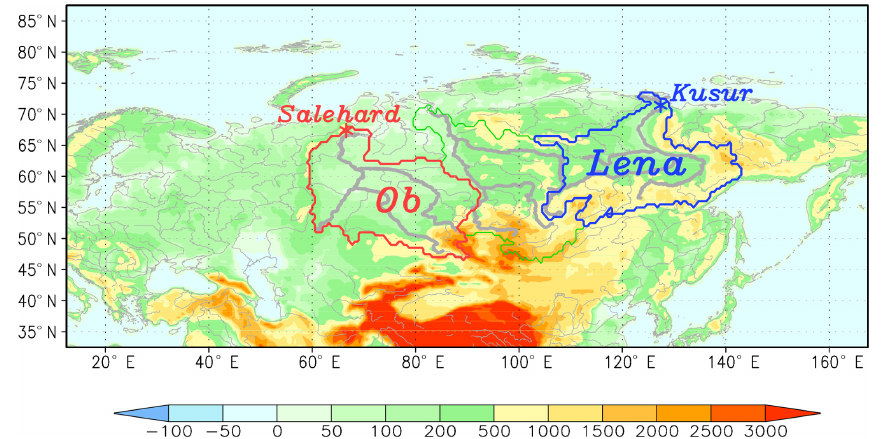
Figure 1. Map of the study area in Siberia. The colored solid contours show the boundaries of each river basin (Lena is in blue and Ob is in red). The asterisks denote the locations of Kusur and Salehard, which are the observation stations nearest the river mouths. The color shades and thick gray lines denote elevation and major flow paths,